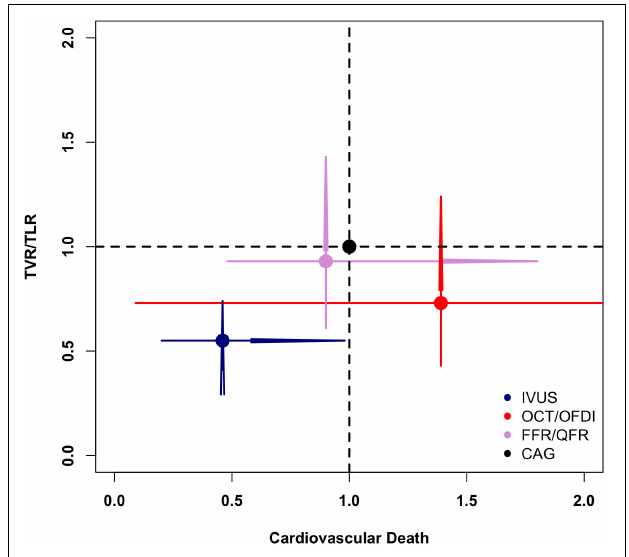
FIGURE 6 | Comparisons of cardiovascular death and target vessel/lesion revascularization in the network meta-analysis. CAG, coronary angiography; FFR, fractional flow reserve; IVUS, intravascular ultrasound; OCT, optical coherence tomography; OFDI, optical frequency domain imaging; QFR, quantitative flow ratio; TVR/TLR, target vessel/lesion